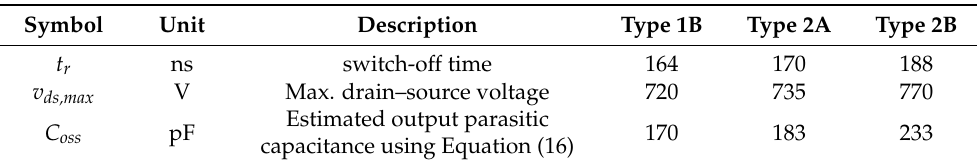
Table 5. Output parasitic capacitance